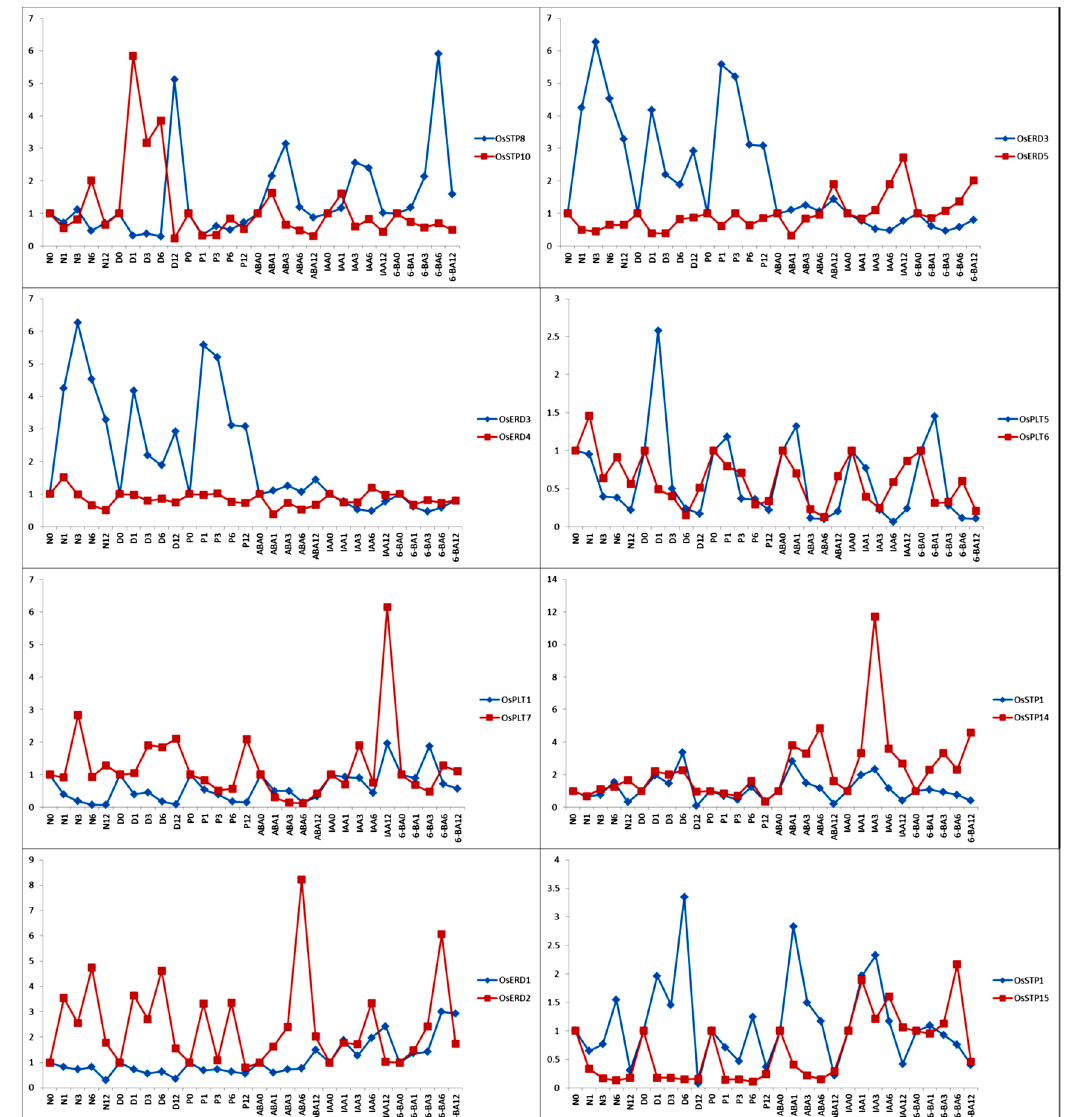
Figure 9. Expression patterns comparison of MST duplicate genes under hormone treatments and abiotic stress treatments. X-axis represents the various points from different treatments. Y-axis on the left indicates the relative values by qRT-PCR. Red numbers represent significant values.